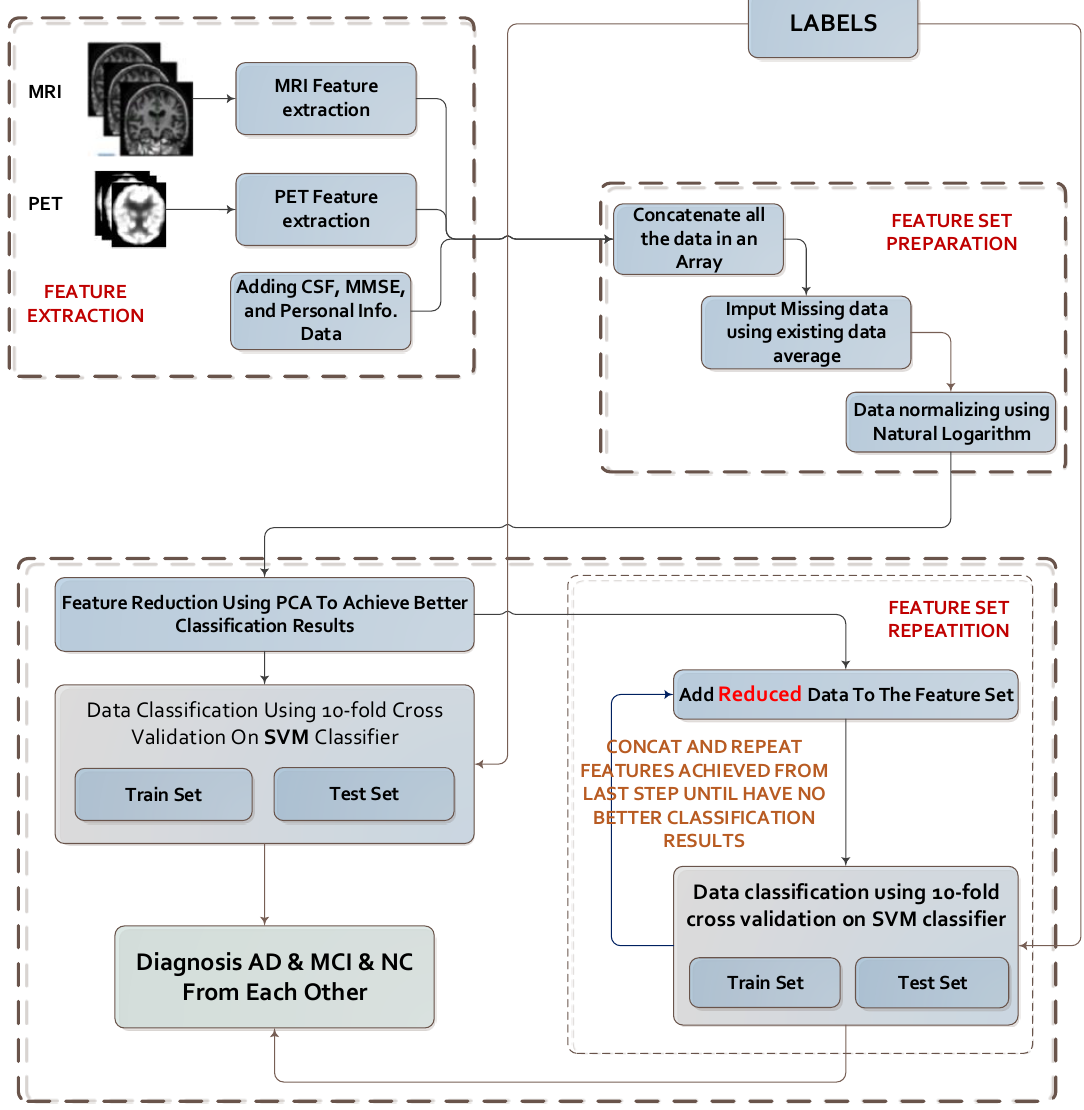
Figure 4. Diagram of steps of the proposed method (Emphasis Learning). CSF: cerebro-spinal fluid.